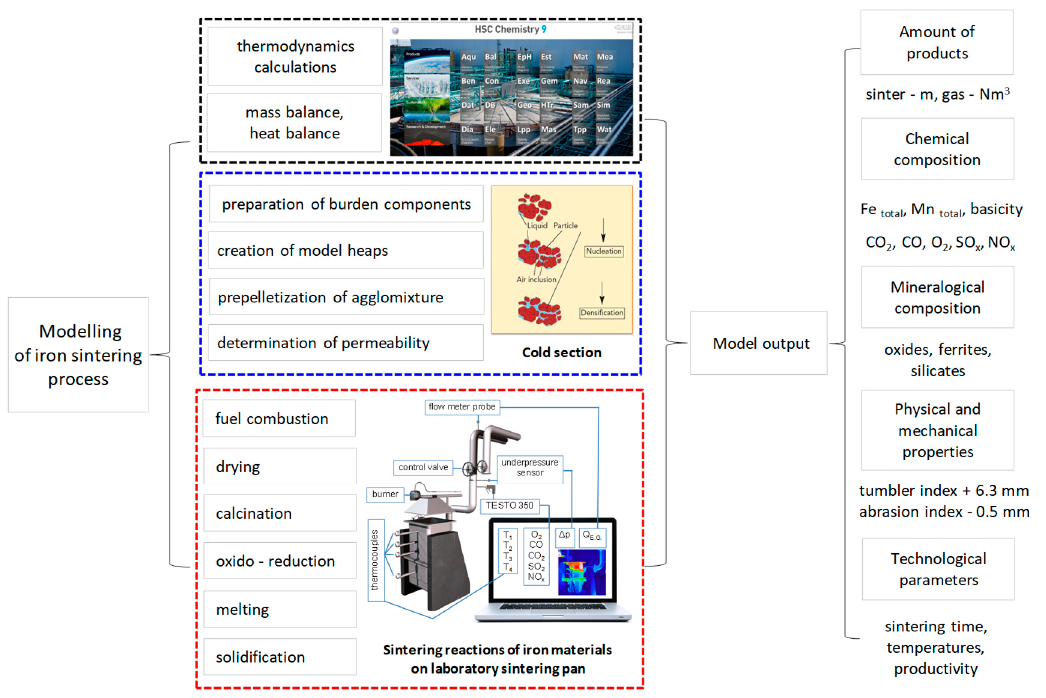
Figure 5. Scheme presenting the global method with modeling of the iron sintering process.